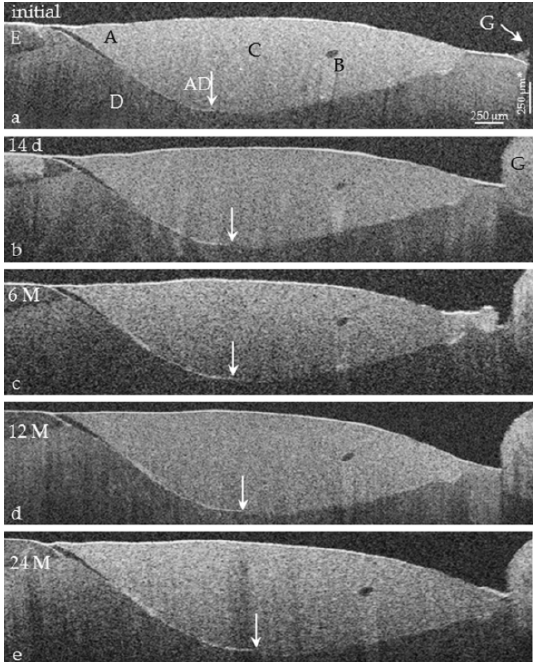
Figure 21. Monitoring of tooth ‐ composite bond using SD ‐ OCT in vivo. ( a ) A cervical composite restoration (C) immediately after filling the cavity in small composite increments. The gingiva (G) is slightly retracted. The composite has been homogeneously dispersed. Initially the bright line marks an extensive adhesive defect (AD) at enamel (E) and dentin (D); ( b – e ) The same cross ‐ section (see bubble in composite, B), imaged using OCT in the period 14 days ( b ) to 24 months (M, e ); the interfacial gap has progressed slightly (bright line, white arrow). There are no signs of secondary caries. A distinct adhesive layer (A) could only be partially detected. * Vertical bar is related to refractive index n = 1.5.